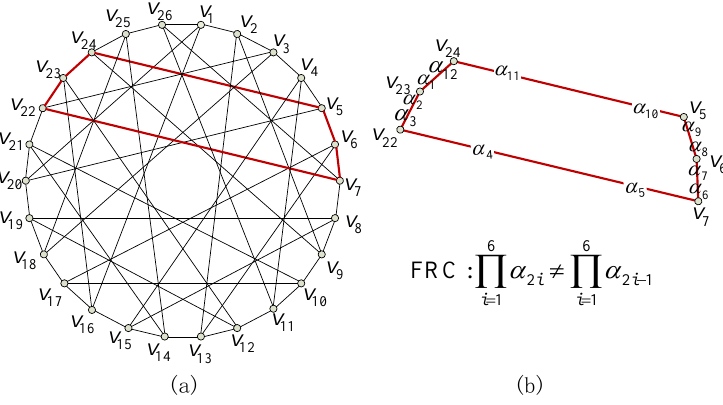
Figure 2. ( a ) The Hamiltonian graph with 26 vertices. ( b ) A cycle in the graph and its full rank condition (FRC). Let α 1 , α 2 , · · · , α l be the non-zero elements of Galois field GF( q ) related to a cycle of